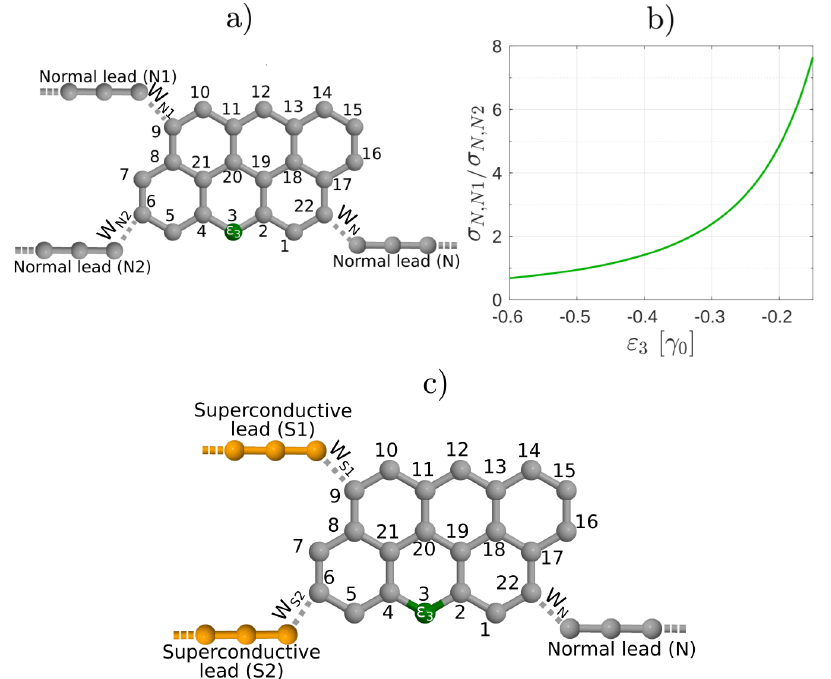
Figure 6. ( a ) Schematics of Anthanthrene molecule with a heteroatom denoted by green. ( b ) Ratio of the normal conductance between contacts N − N 2 and N − N 1 as a function of the on-site energy ε 3 in Figure 6. At ε 3 = 0 the conductance σ N , N 1 between contacts N and N 1 is much larger than the conductance σ N , N 2 between contacts N and N 2, in agreement with References [12,23]. For finite ε 3 the conductance σ N , N 2 increases and can be comparable to σ N , N 1 . ( c ) Andreev interferometer setup obtained by replacing the normal leads N 1 and N 2 in ( a ) by superconducting ones S 1 and S